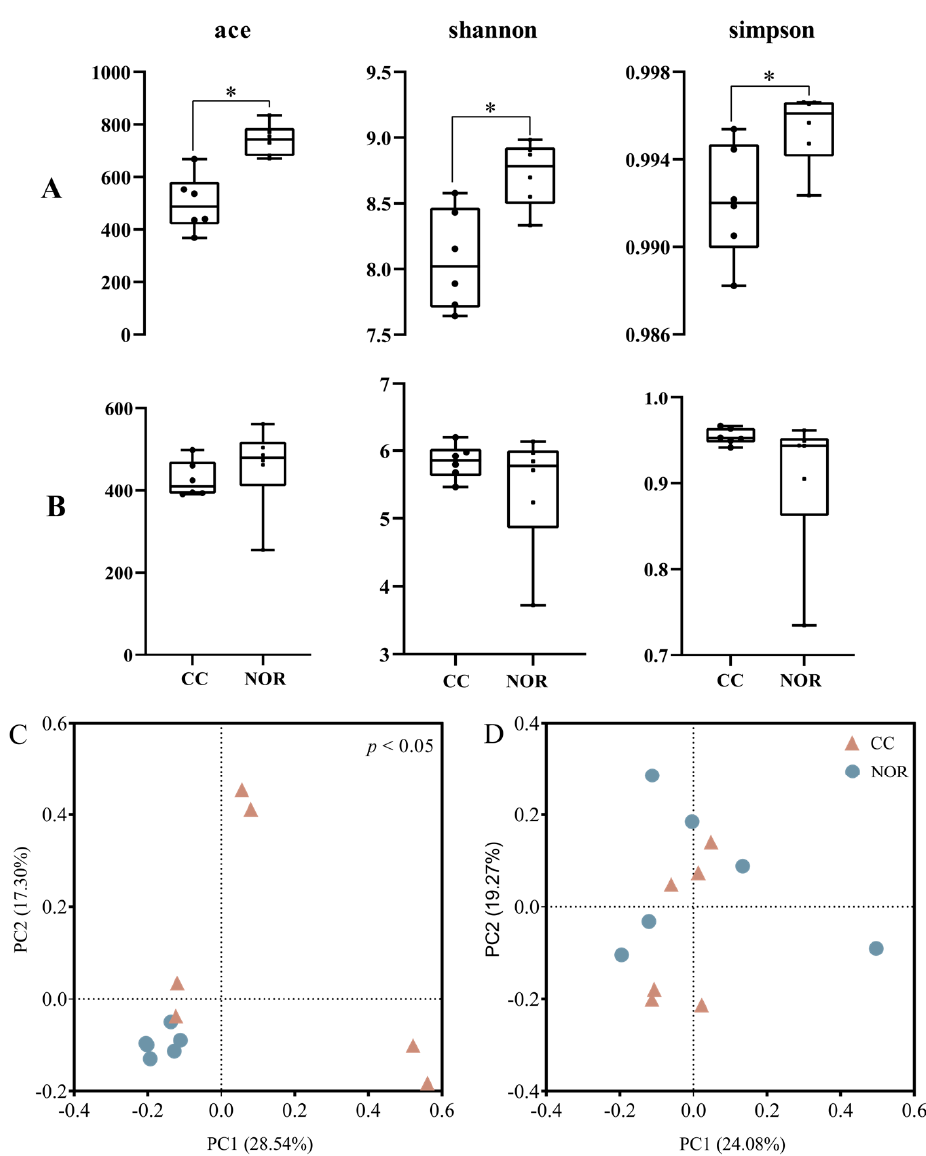
Figure 3. Diversity of rhizosphere microbial community. ( A ): The α diversity of bacterial community; ( B ): the α diversity of fungal community; ACE representative of the abundance-based coverage estimator; Shannon representative of shannon indices; Simpson representative of Simpson indices; CC represents continuous cropping obstacle field tobacco; NOR represents normal field tobacco; asterisk (*) indicates significant differences ( t- test, p < 0.05). Error bars are standard errors; ( C ): the principle coordination analysis (PCoA) and permutational multivariate analysis of variance (PERMANOVA, by Adonis) analysis based on the Bray–Curtis distance revealed distinct differences in rhizosphere soil bacterial community structure between CC and NOR ( p < 0.05); ( D ): the PCoA and PERMANOVA (by Adonis) analysis based on the Bray–Curtis distance revealed distinct differences in rhizosphere soil fungal community structure between CC and NOR.